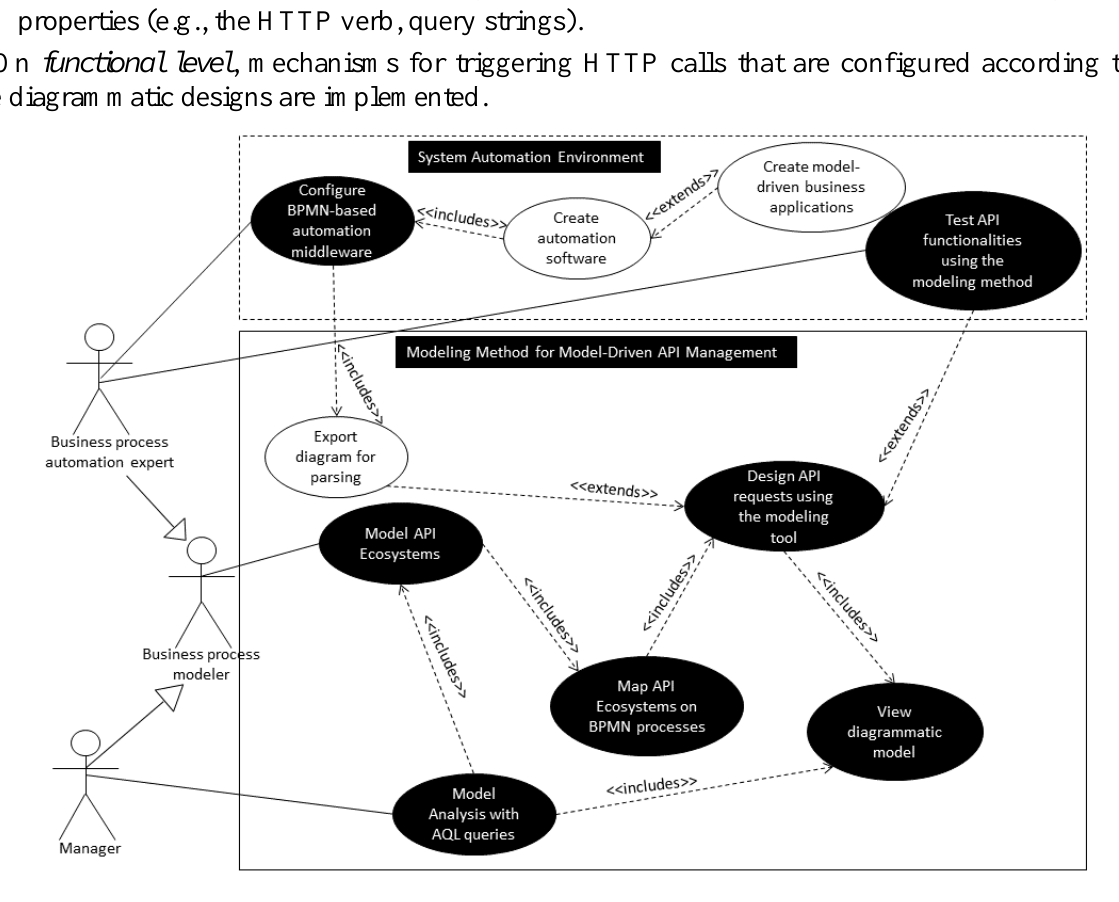
Figure 2. Stakeholders and supported use